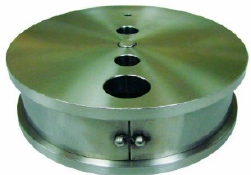
Figure 1. API Compressive Strength Tester.